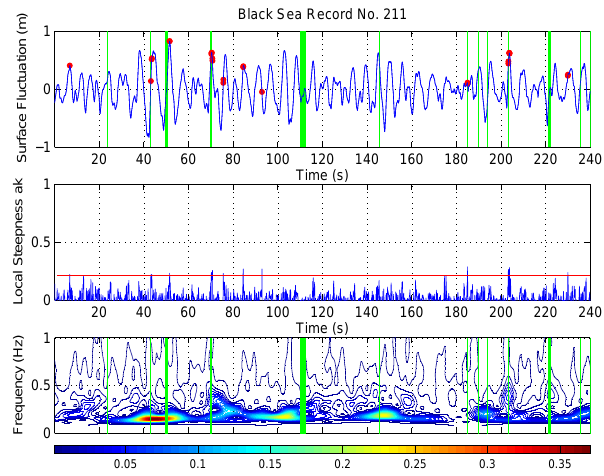
Fig. 4. ( a ) Comparing breaking events detected from wavelet ap- proach in red dots with Black Sea measurement in green vertical bars. ( b ) Local steepness ak . The straight line shows γ = 0 . 2, the chosen threshold value. ( c ) Instantaneous wave spectra in relative units (colour scale below). The horizontal axis is the time axis, same as in the top two